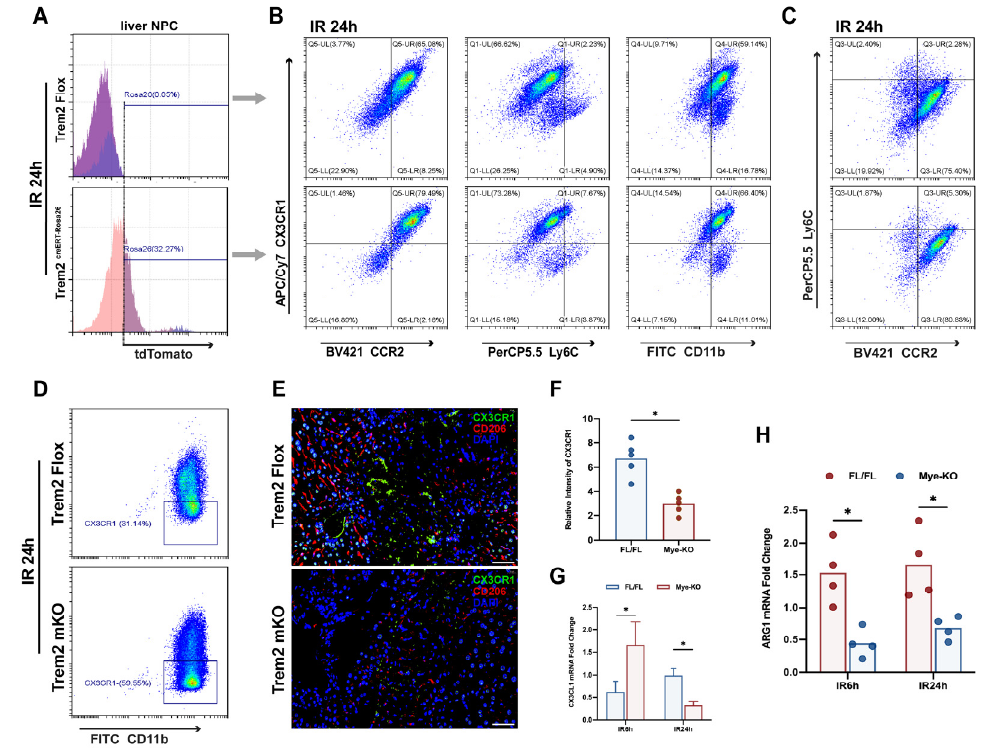
Figure 4. Reprogramming of mono-derived macrophages depends on myeloid Trem2. After 5 days of intraperitoneal injection of tamoxifen into Trem2 creERT Rosa26 Tdtomato mice and Trem2 Fl/FL mice, a liver IR operation was performed. After 24 h, liver NPCs were isolated, and the ( A ) overexpression efficiency of Tdtomato labeling was verified by flow cytometry. ( B , C ) the expression of CX3CR1, Ly6C, CCR2, and CD11b in the liver NPCs of Trem2 creERT Rosa26 Tdtomato and Trem2 Fl/FL in IR24h was detected by flow cytometry; ( D ) The expression of CX3CR1 in the liver of Trem2 FL/FL or Trem2 mKO at IR24h was detected by flow cytometry; ( E ) The expression of CX3CR1 and CD206 in Trem2 FL/FL or Trem2 mKO livers was detected by immunofluorescence (scale bars = 100 μ m) and ( F ) the fluorescence intensity was quantified by ImageJ ( n = 5/group, * p < 0.05); The mRNA levels of ( G ) CX3CL1 and ( H ) Arg1 in the livers of Trem2 FL/FL or Trem2 mKO at IR24h were detected by qPCR ( n = 4–5/group, * p < 0.05).